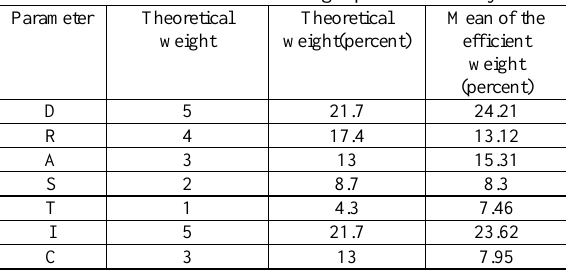
Table 1: Statistical results of single parameter analysis